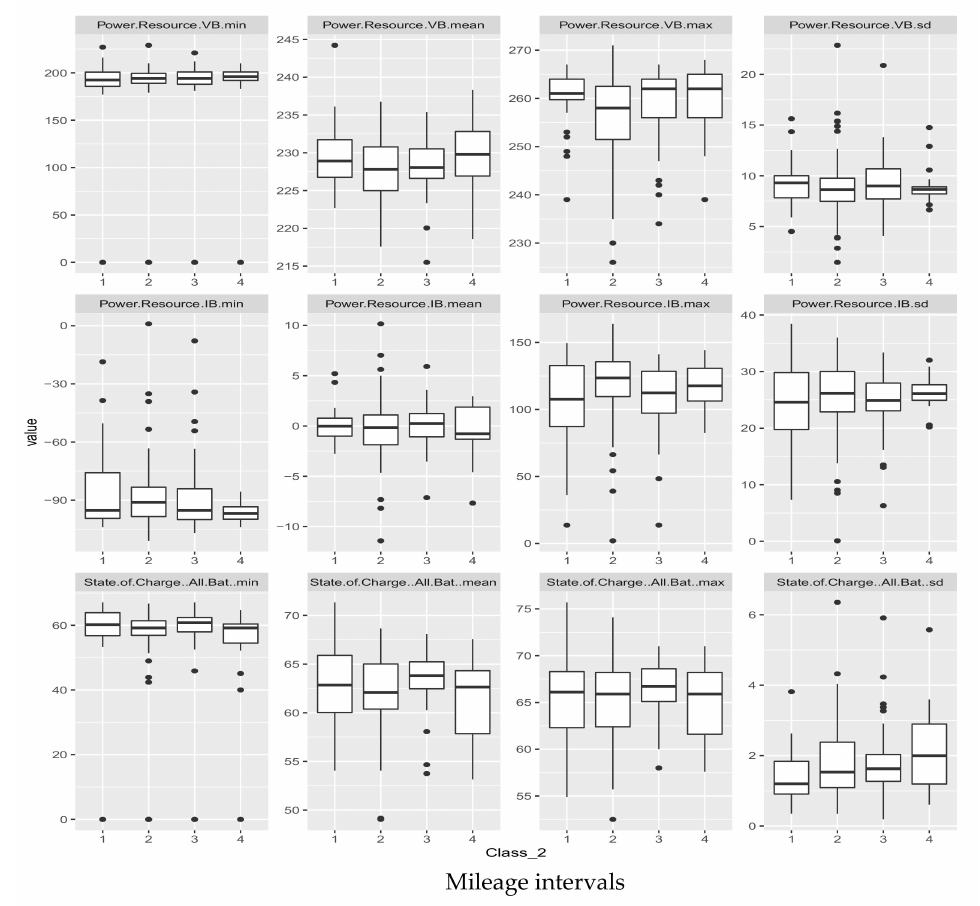
Figure 4. Boxplot of VB, IB, SOC statistics according to mileage